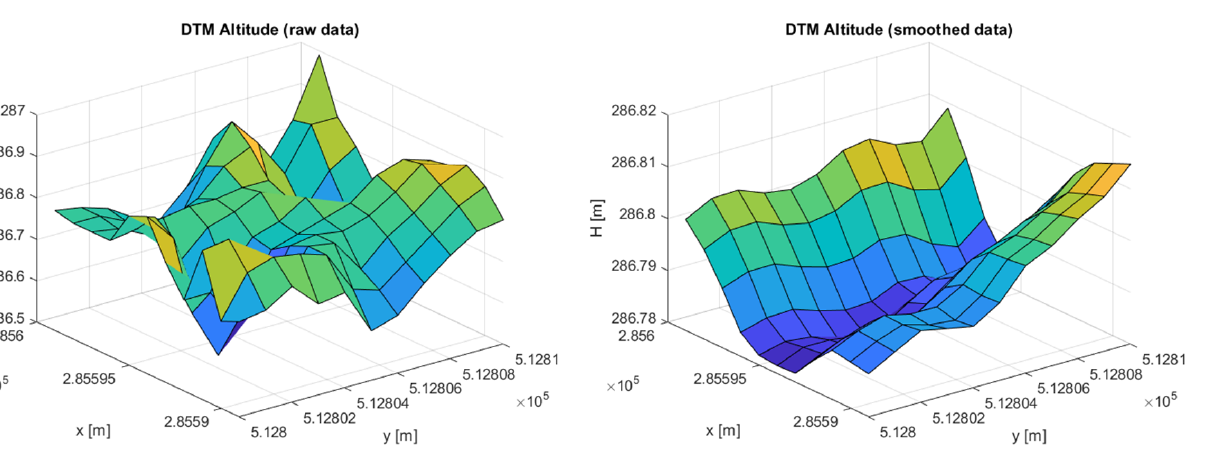
Figure 8. DTM altitude map.